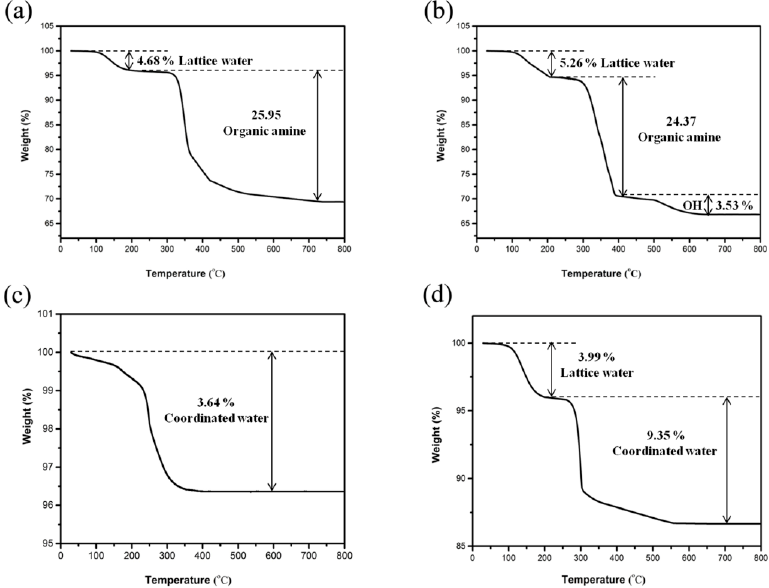
Figure 12. Thermal gravimetric (TG) curves of compound ( a ) 1, ( b ) 2, ( c ) 3, and ( d ) 4.